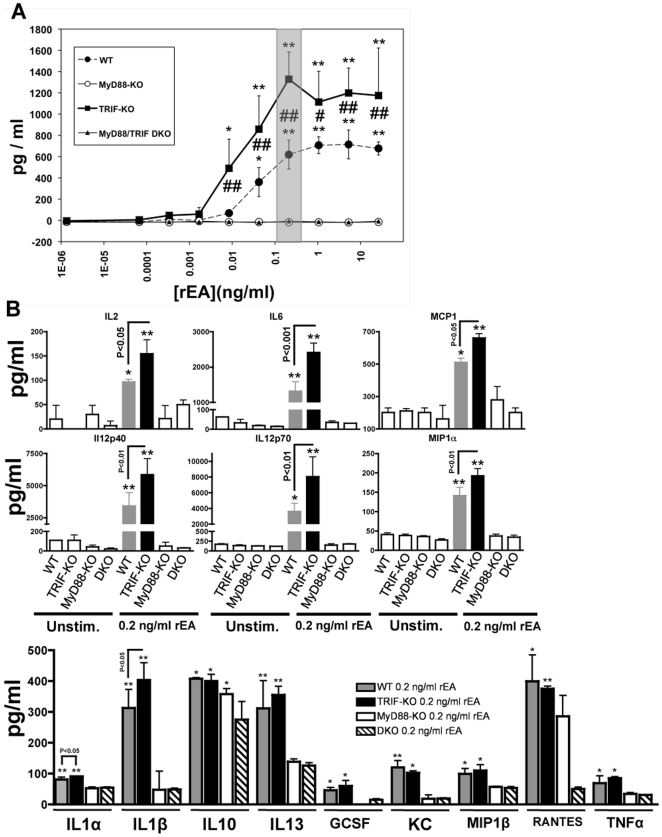
TRIF negatively regulates rEA-mediated MyD88 dependent activation of pro-inflammatory cytokines and chemokines in dendritic cells.(A) CD11c+ dendritic cells were isolated from C57BL/6 WT (N = 2), MyD88-KO (N = 2), TRIF-KO (N = 2), and MyD88/TRIF-DKO (N = 2) mice, in vitro stimulated with rEA, then used to perform a IL12p70 ELISA as described in Materials and Methods. One (of three) representative experiments is shown. The bars represent Mean ± SD. Statistical analysis was completed using a two-way ANOVA with a Bonferroni post-hoc test (genotypes×rEA treatments). *, ** - Indicate values that are statistically different from those in unstimulated DCs (for the same genotype), p<0.05, p<0.001 respectively. #, ## - Indicate values statistically different from those in WT DCs (for the same rEA dose), p<0.05, p<0.01 respectively. No significant differences between mock-injected animals of different genotypes were detected. No significant activation of IL12p70 was observed in MyD88-KO and MyD88/TRIF-DKO DCs. (B) DC culture media was collected at 18 hours post-rEA stimulation (0.2 ng/ml) and was analyzed for cytokines/chemokines levels using a multiplexed bead array based quantitative system. Statistical analysis was completed using a one-way ANOVA with a Student-Newman-Keuls post-hoc test. The bars represent Mean ± SD. *, ** - Indicate cytokine values that are statistically different from those in mock injected animals, p<0.05, p<0.001 respectively. No significant differences between mock-injected animals of different genotypes were detected. No significant activation of pro-inflammatory cytokines was observed in MyD88-KO and MyD88/TRIF-DKO animals (only anti-inflammatory IL10 cytokine was induced in MyD88-KO mice).